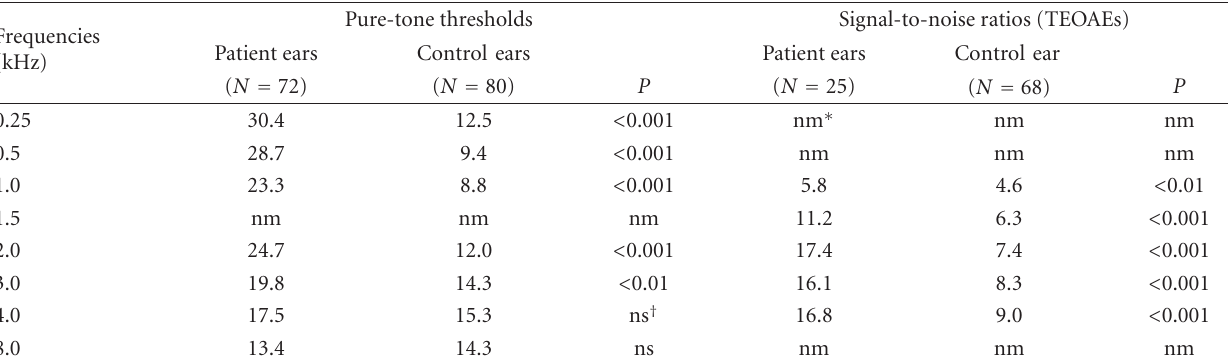
Table 1: Means and levels of statistical significance ( P ) of pure-tone thresholds and signal-to-noise ratios of transiently evoked otoacoustic emissions (TEOAEs), comparing the ears of patients and the ears of